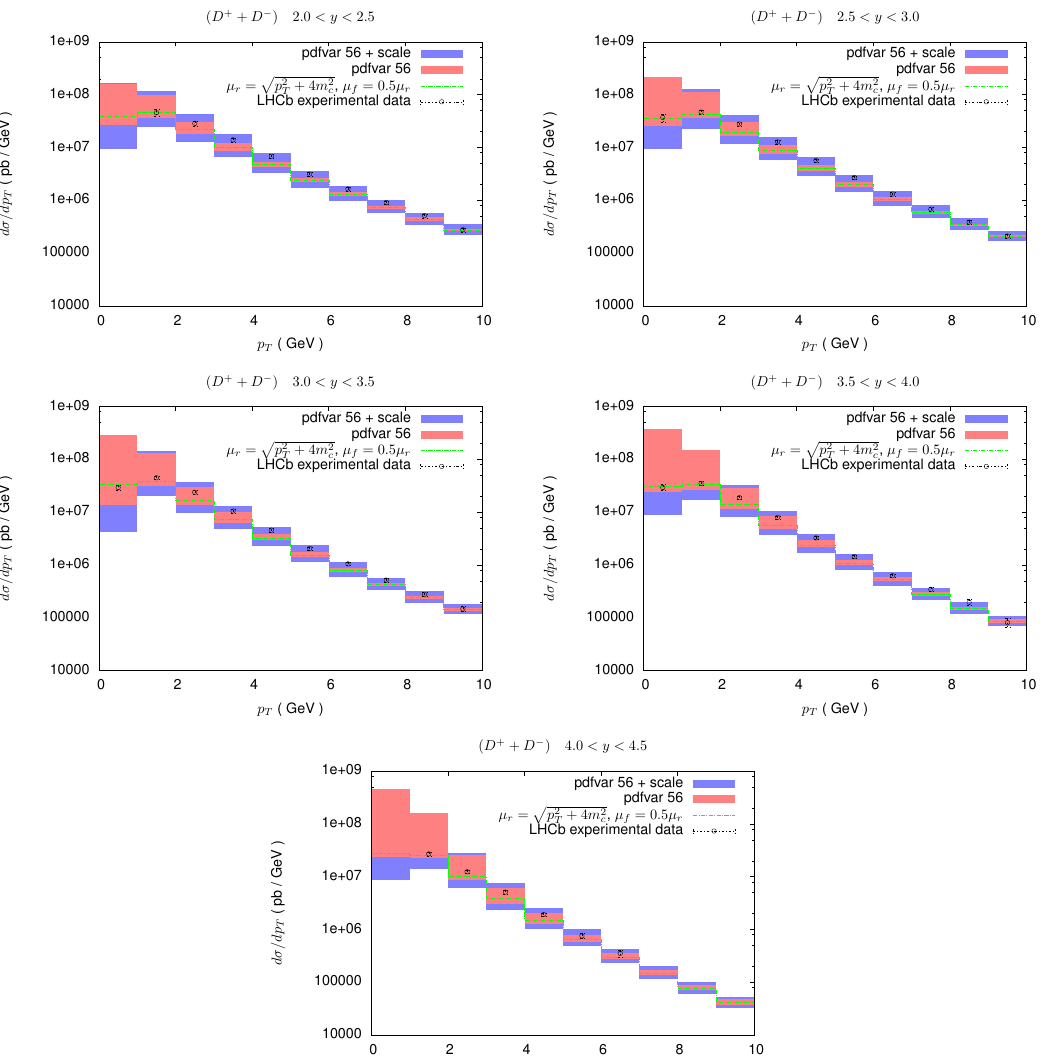
Figure 17 . Our GM-VFNS predictions for ( D + + D (cid:0) ) transverse-momentum distributions in pp collisions at p S = 5 TeV vs. LHCb experimental data of ref. [43]. Each panel corresponds to a di(cid:11)erent rapidity bin in the interval 2 < y < 4.5. The renormalization scale (cid:22) r is chosen as p 2 + 4 m 2 , and varied in the [0.5, 2] interval around this central value. The PDF uncertainties c T are computed as explained in section 5, while the combined uncertainty is determined by adding p the scale and PDF uncertainties in